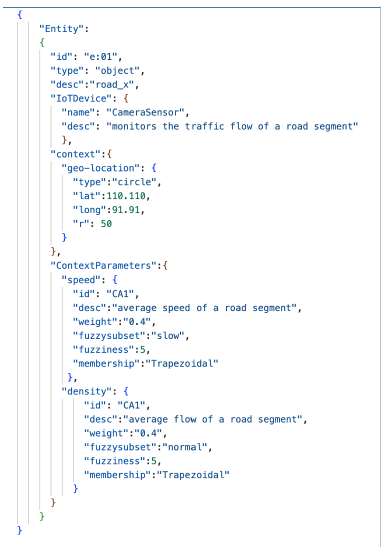
Figure 15. Sample JSON representation for an entity.